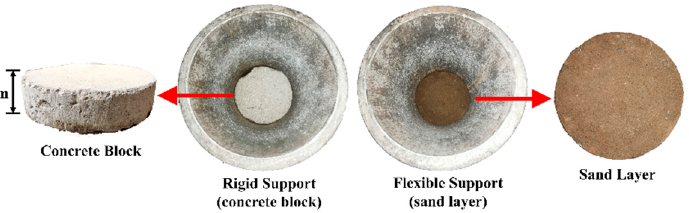
Figure 5. Illustration of the concrete block and sand layer used to represent rigid and soft under- ballast support, respectively.